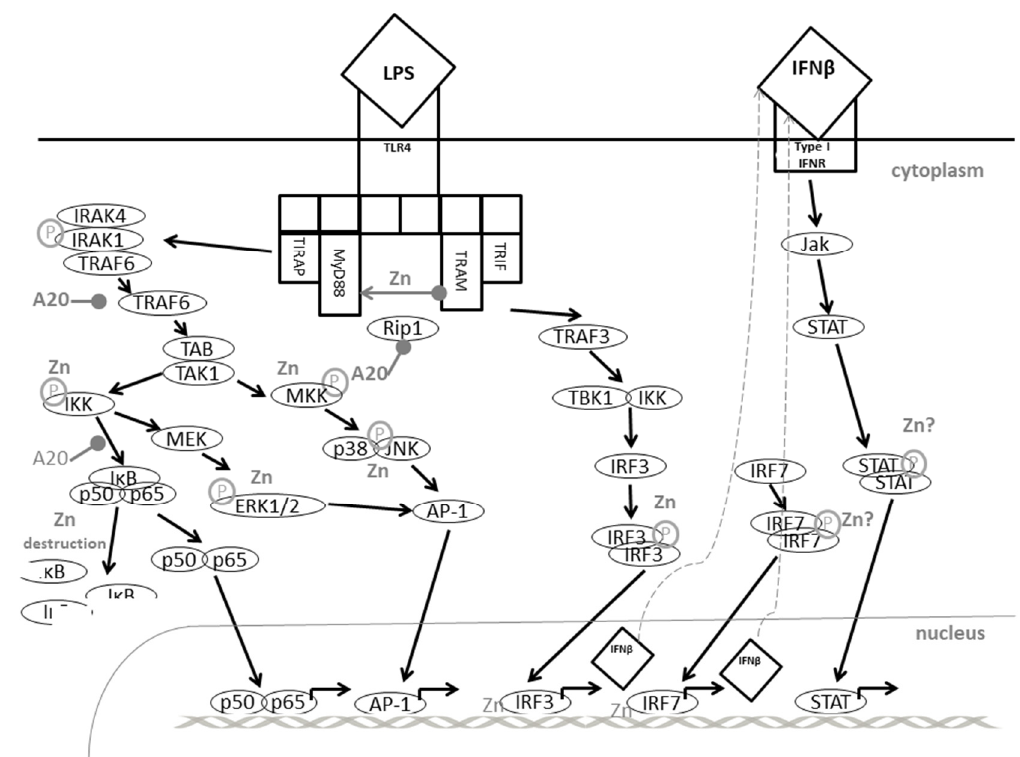
Figure 2. Zinc in Toll like receptor 4 ‐ induced signaling. For explanation, see text. Abbreviations: